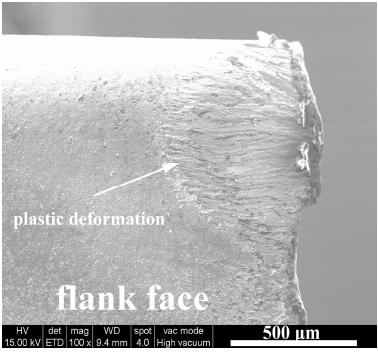
Figure 6. SEM image of flank face of the TiAlN-coated insert after machining for 6 min (cutting speed of 70 m/min, feed rate of 0.1 mm/r, depth of cut of 1.0 mm).